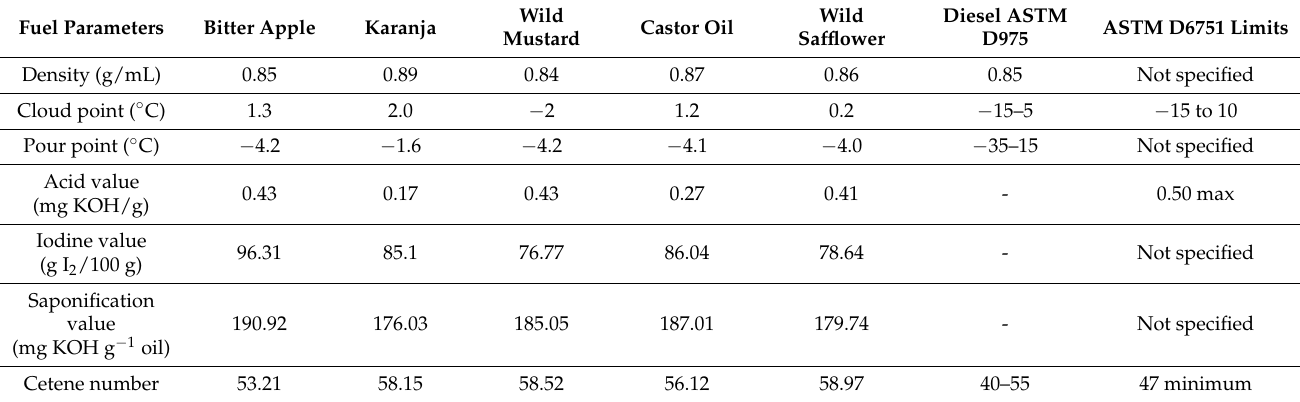
Table 8. Fuel properties of FAME produced from various